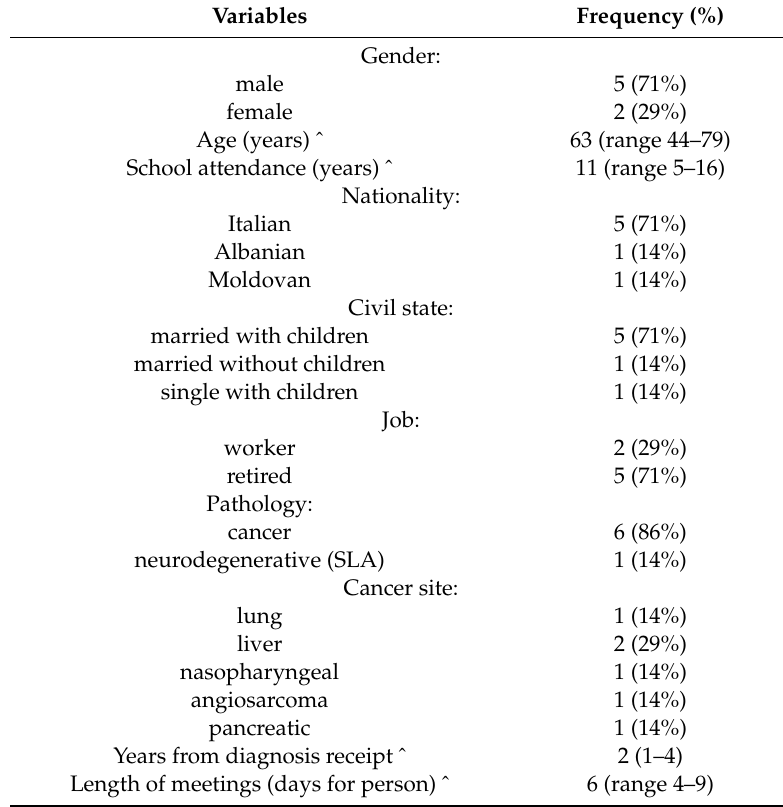
Table 1. Participants’